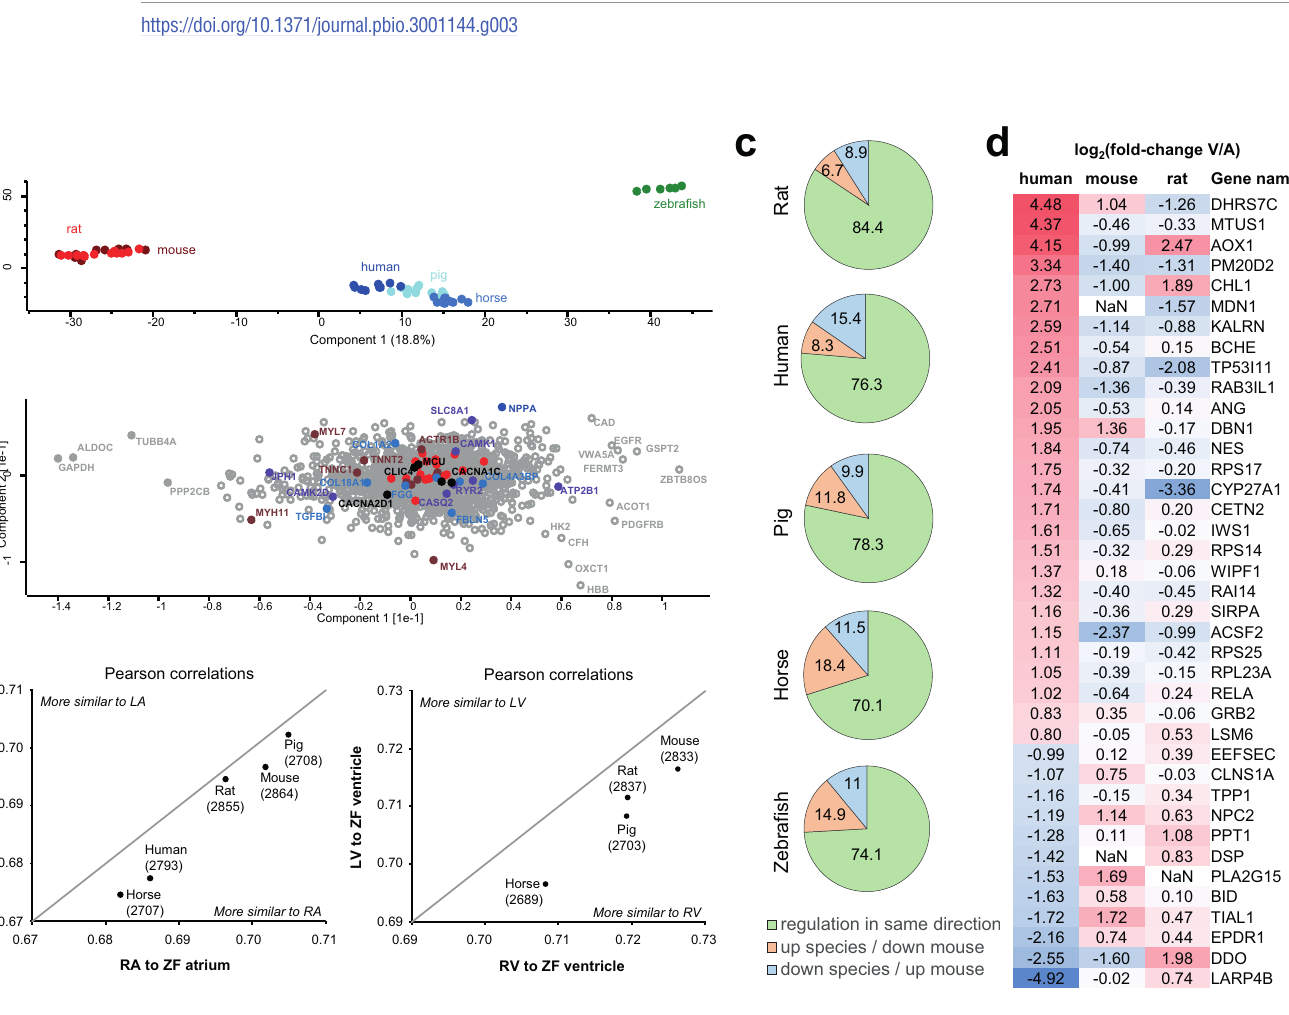
Fig 4. Species-specific differences in protein abundance profiles. (a) PCA (top) shows that the main sources of variation in the dataset are contributed by (i) the zebrafish samples (green) being different from all mammalian samples; and (ii) small mammals (red) being different from large mammals (blue). Analysis of which proteins explain most of the sample variance between samples (bottom) highlights, e.g., MYL4 and MYL7 showing high variance between zebrafish and large mammals along component 2, as well as NPPA, MYH11, and SLC8A1 highlighted as major contributors to the intermammalian differences. Reference sets of mitochondrial proteins are highlighted in orange, which show comparably lower loadings. This analysis is based on data presented in S8 Table. (b) Analysis of zebrafish protein abundance profile in atria and ventricle compared to corresponding mammalian protein abundance profiles in left and RV and atria. Pearson correlation analysis across all proteins consistently shows higher similarity to right side of the mammalian hearts, for ventricle as well as atria. This analysis is based on data presented in S8 Table. (c) Comparison of protein abundance differences between atria and ventricles across species. Protein abundances in ventricle compared to atria were calculated for mouse heart, and ratios were compared to all other species. Pie charts illustrate the percentage of proteins showing same direction of regulation (green), higher abundance in atria in other species in contrast to mouse (orange), and higher abundance in ventricle in other species contrary to finding in mouse (blue). (d) Proteins significantly differentially expressed between human ventricle and atria, which show opposite abundance profile in mouse and/or rat compared to human. log2 fold change of atria versus ventricle are shown, i.e., proteins higher expressed in ventricle are denoted positive (red), and those higher expressed in atria are denoted